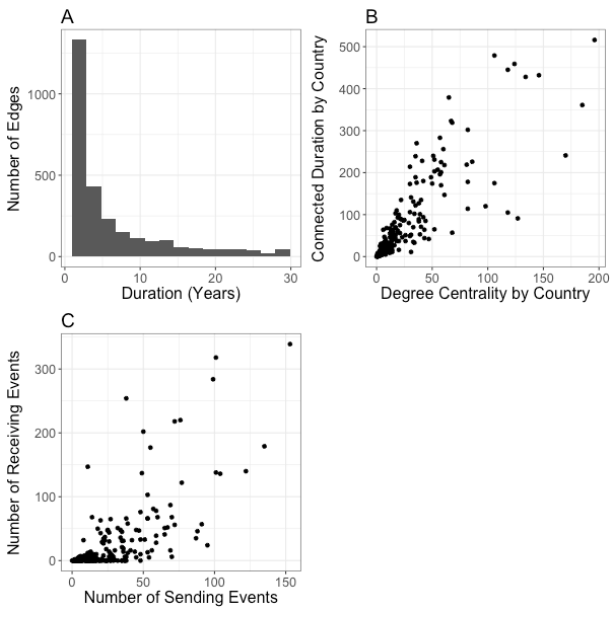
Fig. 5 . Assessment of relationships across the soybean metacoupled system from 1986 to 2013: (A) histogram of durations of all trade partnerships in years for all countries, (B) degree centrality on the y-axis and total duration in years that each country has multiyear trade partnerships on the x-axis, (C) number of sending events relative to receiving events for each